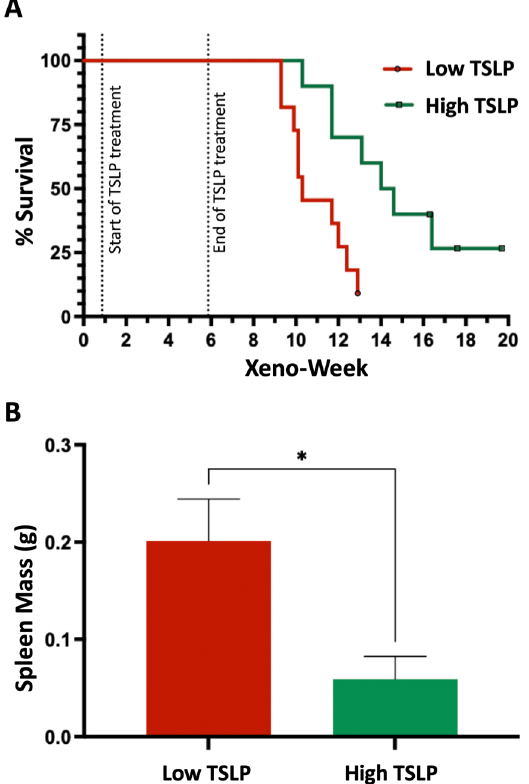
Figure 3. High TSLP doses prolonged survival of PDX mice. ( A ) Survival curves shown for patient-1- derived xenograft (PDX-1) with TSLP treatment (low and high) starting 1 week after transplantation and ending at week 6. n = 21 (11 low-TSLP and 10 high-TSLP). A Mantel–Cox (log-rank)